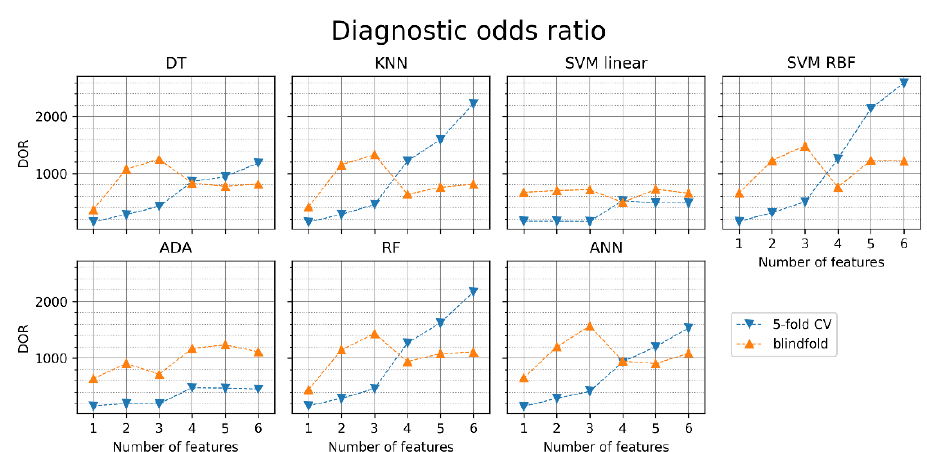
Figure 9. The diagnostic odds ratio (DOR) of AF detection for different classifiers with sets of one to six features (orange points — blindfold validation, blue points — 5-fold cross-validation). DT — decision tree, KNN — K nearest neighbors, SVM linear — support vector machine with linear kernel, SVM RBF — support vector machine with radial basis function kernel, ADA — Ada Boost, RF — random forest, ANN — artificial neural network.